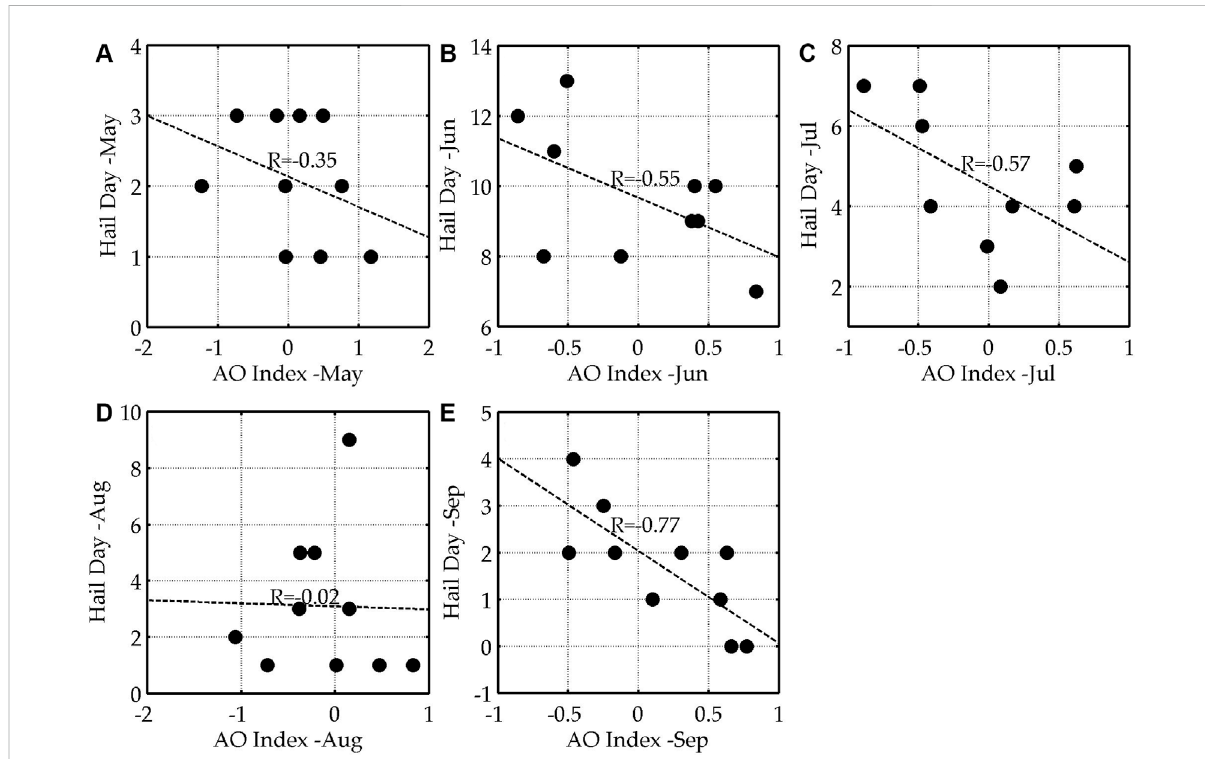
FIGURE 9 The scatterplots of monthly mean AO Index and monthly hail days in each month from 2011 to 2021: (A) in May; (B) in June; (C) in July; (D) in August; (E) in September. Dash lines intheplots show thelinear fi tting line.Textsintheplots show thecorrelation coef fi cient betweenAOIndex and hail days in each